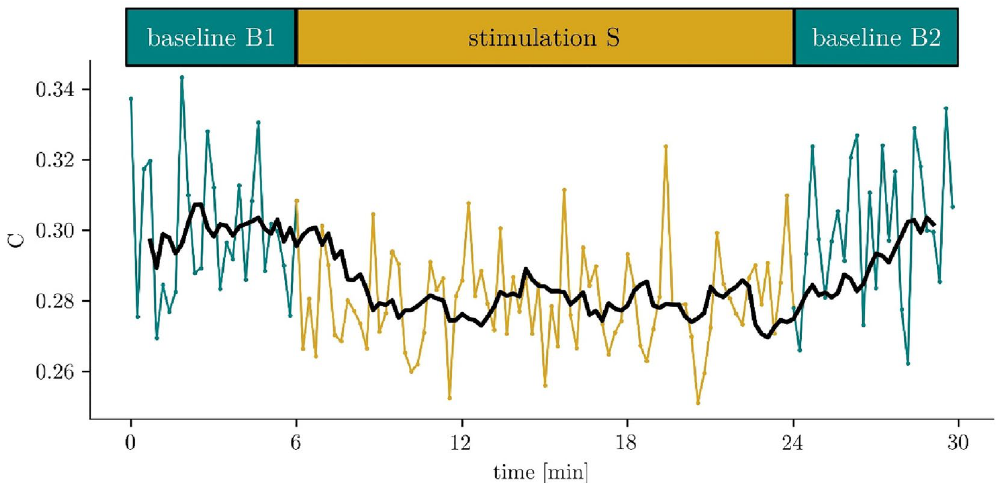
Figure 1. Top: examination schedule comprising two baseline conditions (6 min. each) prior to and after a multisensory stimulation block (18 min.) probing the somatosensory, auditory, and visual modalities. Bottom: exemplary temporal evolution of the clustering coefficient along the examination schedule. A 7-point sliding average is indicated by the black line.